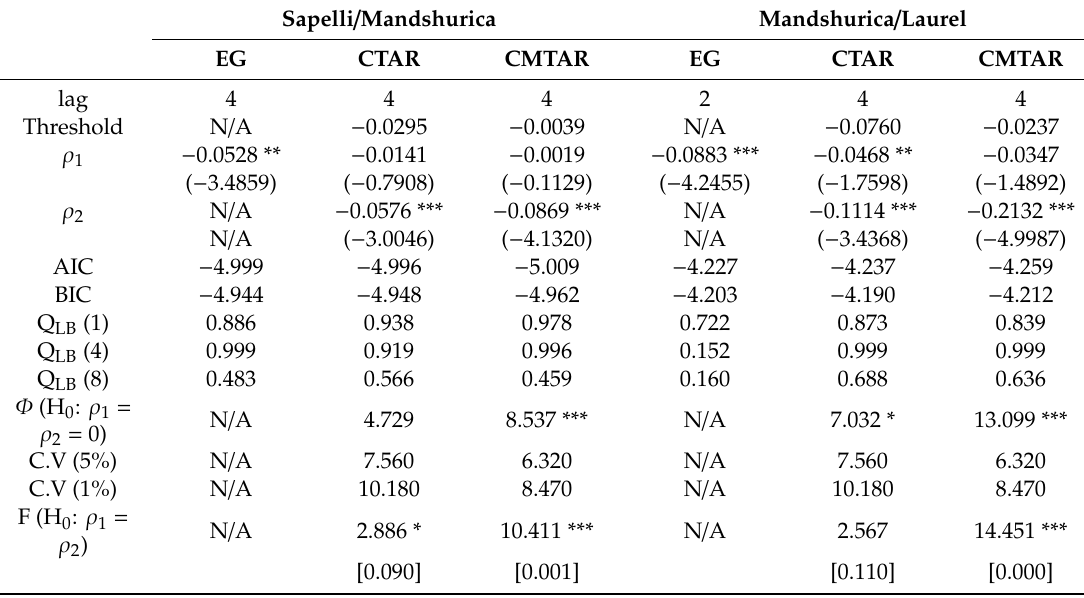
Table 5. Results of the Engle–Granger and threshold cointegration model for the first subperiod.